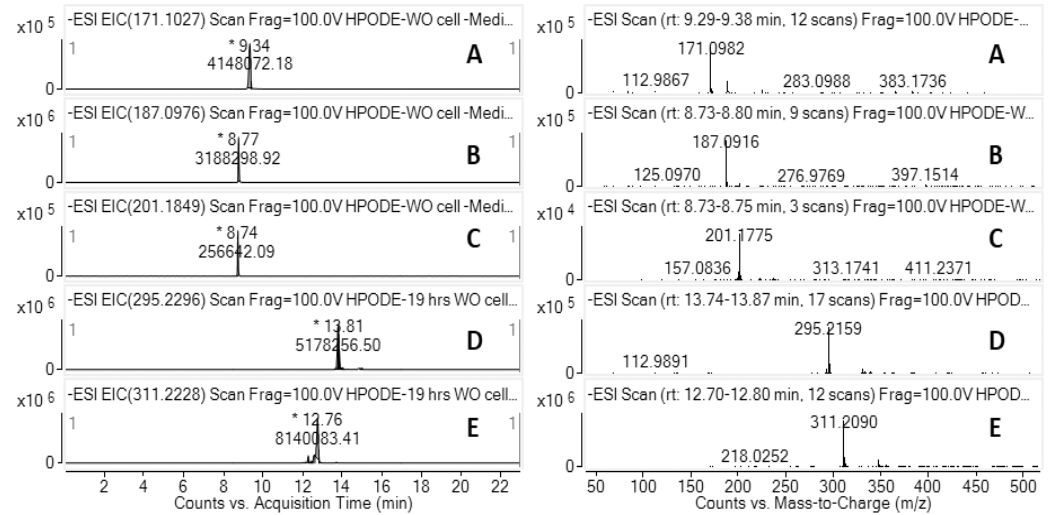
Figure 3. Representative overlaid LC-HRMS data from fully differentiated Caco-2 13-HPODE decomposition ( n = 3). EIC (left panel) and ESI mass spectra (right panel) for ( A ) 9-ONA, ( B ) AzA, ( C ) AzA-D14 (IS), ( D ) 13-HODE, and ( E ) 13-HPODE.